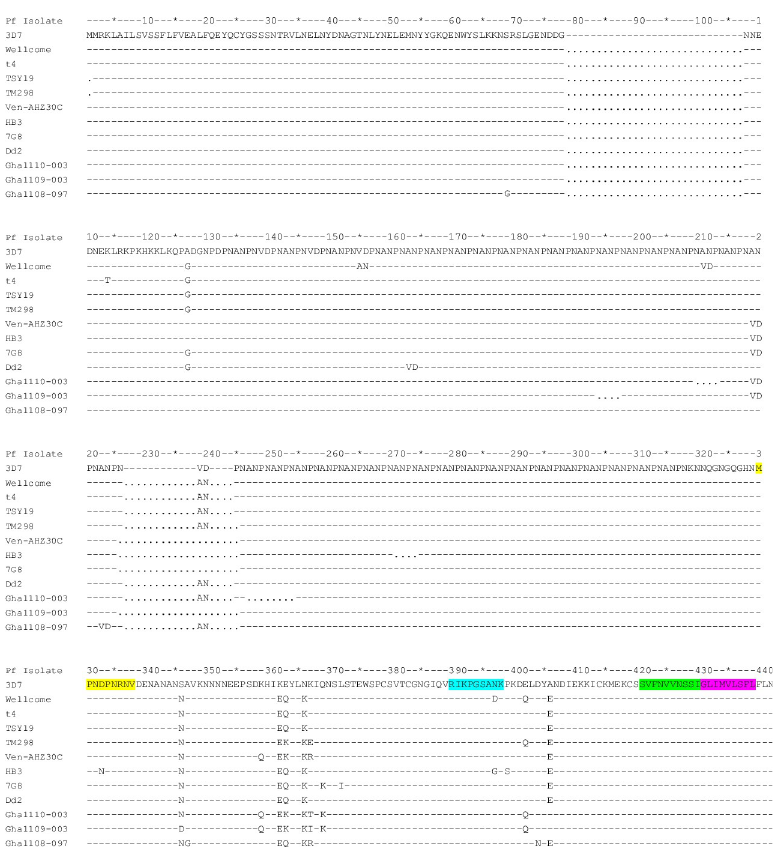
Fig 1. Alignment of PfCSP sequences from multiple Pf strains. Sequences include those from established laboratory parasite strains as well field isolates from Ghana, Nigeria, Venezuela, Thailand. Dash lines represent the conserved residues relative to the 3D7 consensus from which tested peptides were derived. Dots represent deleted sequences compared to the Wellcome sequence, which is the longest in terms of amino acid residues (442). The final four peptides identified as being immunodominant in this study are highlighted in different colours. Sequences were sourced from Genbank and UniProt sequence databases, and alignments to identify deleted residues in some sequences were done in